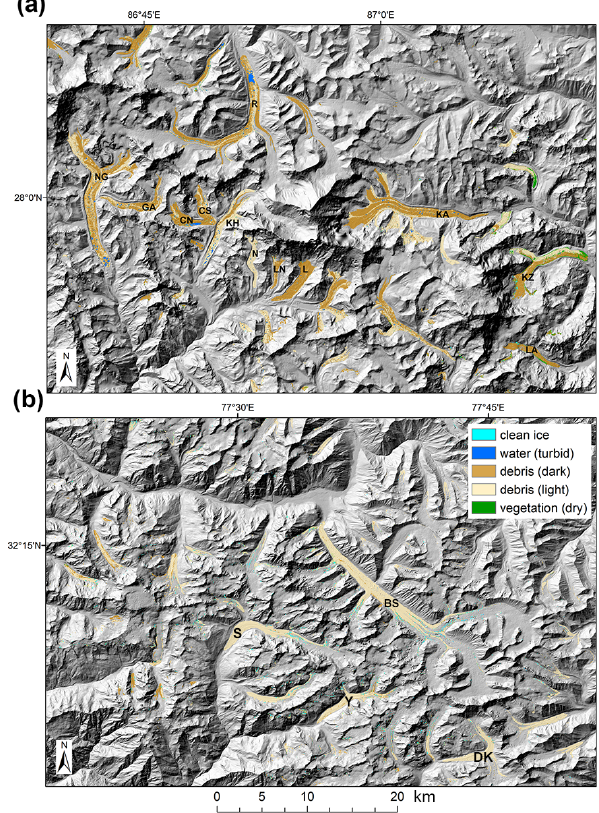
Figure 8. Composition of debris-covered glacier tongues shown for two of the domains showing glaciers discussed in the text: (a) sub- set of the Khumbu domain (NG: Ngozumpa Glacier; GA: Gaunara Glacier; CN: Changri Nup Glacier; CS: Changri Shar Glacier; KH: Khumbu Glacier; N: Nuptse Glacier; LN: Lhotse Nup Glacier; L: Lhotse Glacier; KA: Kangshung Glacier; KZ: Kazhenpu Glacier; LA: Labeilang Glacier) and (b) subset of the Lahaul–Spiti area (BS: Bara Shigri Glacier; S: Sara Umga Glacier; Y: Yichu Glacier; DK: Dibi Ka Glacier). Surfaces are shown on shaded relief from the AW3D30 DEM, with debris-covered glacier extents from the SDC dataset (Scherler et al., 2018). Note that the extent of Changri Nup incorrectly includes the inactive part of the glacier in this global